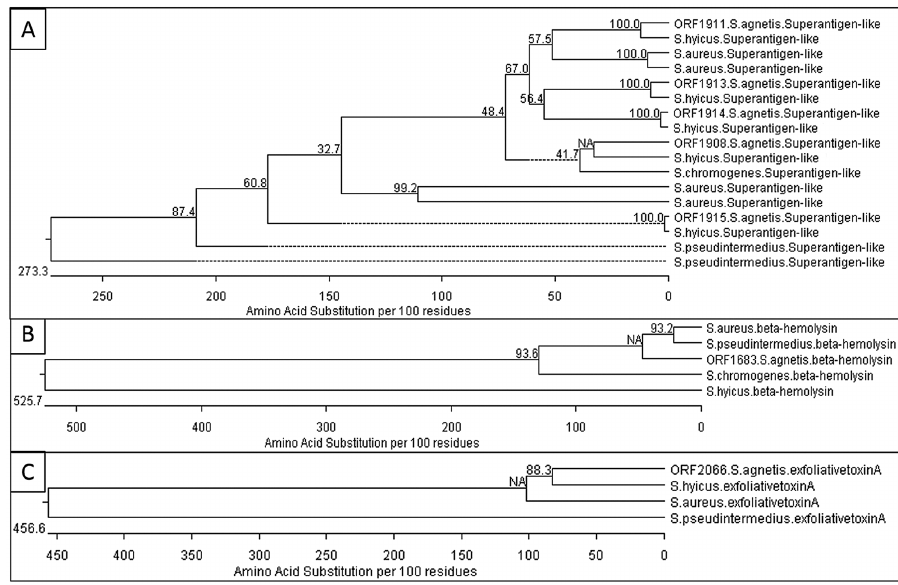
Fig 5. Phylogenetic trees of toxin virulence factors. Trees were constructed using the closest homologs to S . agnetis toxin proteins from BLASTp searches of refseq proteins from S . hyicus , S.chromgenes, S . pseudintermedius and S . aureus . Tress are for Superantigen-like protein homologs (Panel A), beta hemolysin (Panel B), and exfoliative toxin A (Panel C). The S . agnetis ortholog are prefixed with the ORF number from S1 Table. Details of the alignment strategy are in Materials and